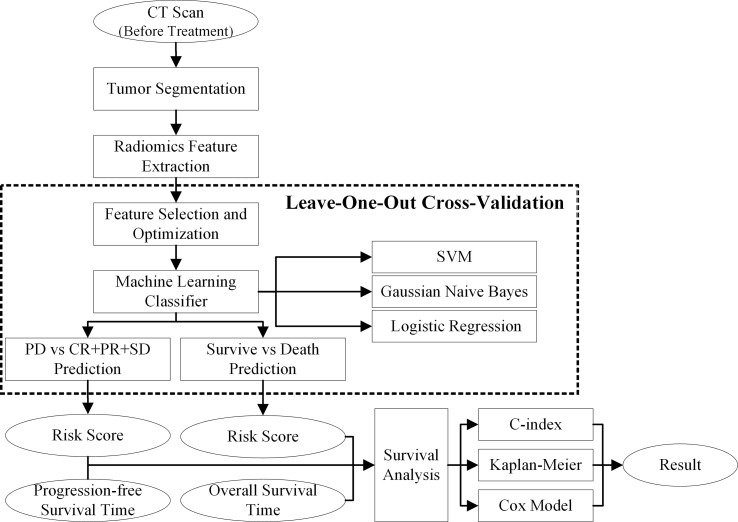
Flowchart of our proposed model.